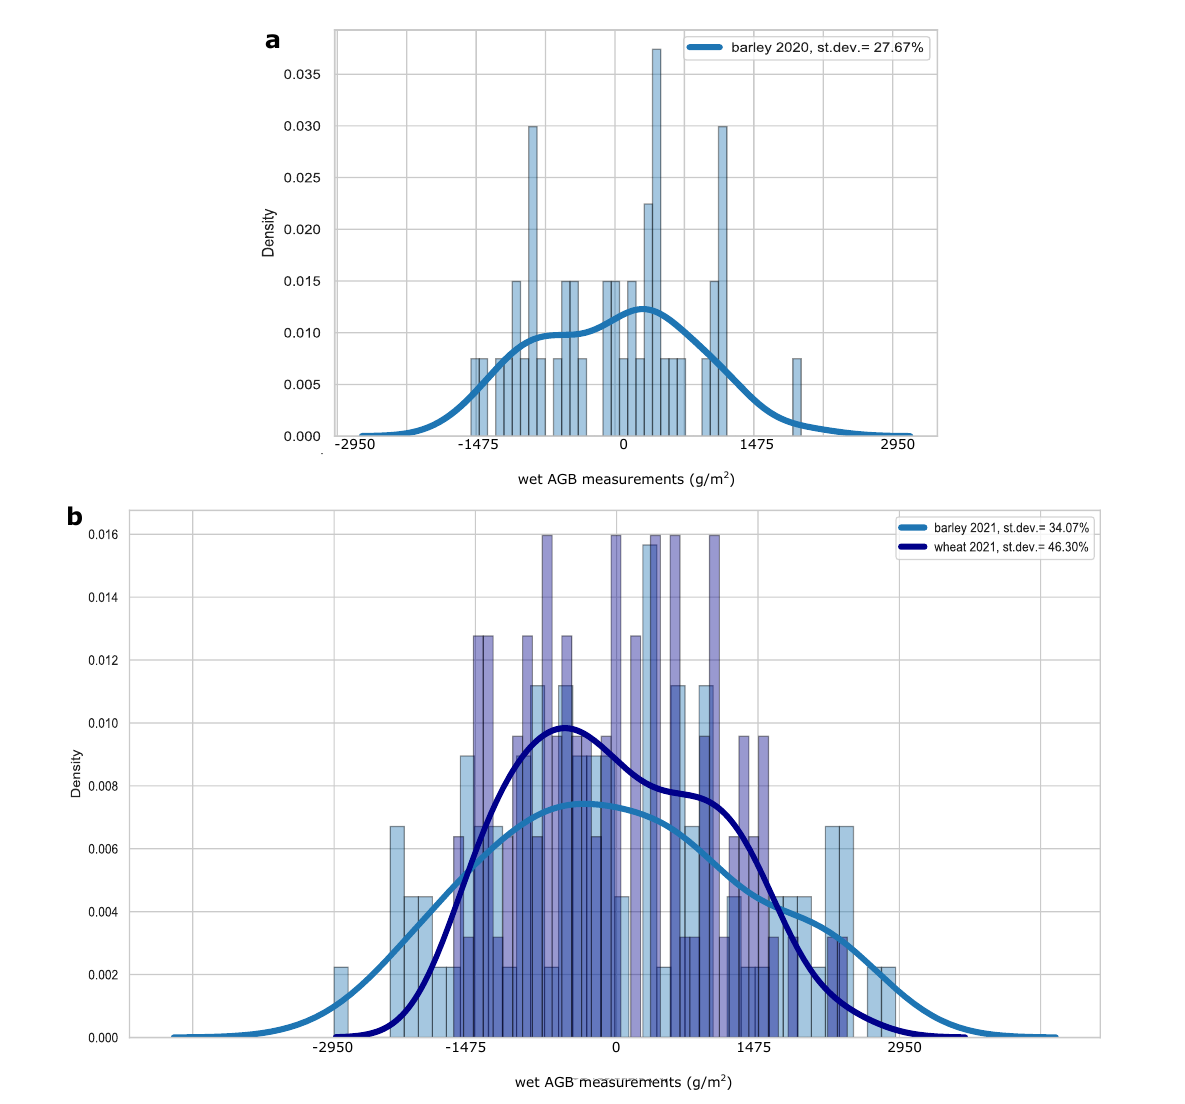
Figure A1. The variance of measurements of wet AGB value per sample (upscaled to g/m 2 ) with respect to the total wet AGB value in an area of 1 m 2 (which was set as a reference at 0 g/m 2 ): ( a ) the 2020 barley dataset (sample size: 1 × 0.35 m 2 ); ( b ) the 2021 wheat and barley datasets (sample size: 0.5 × 0.35 m 2 ). In both ( a , b ), the solid lines represent the estimation of the kernel probability